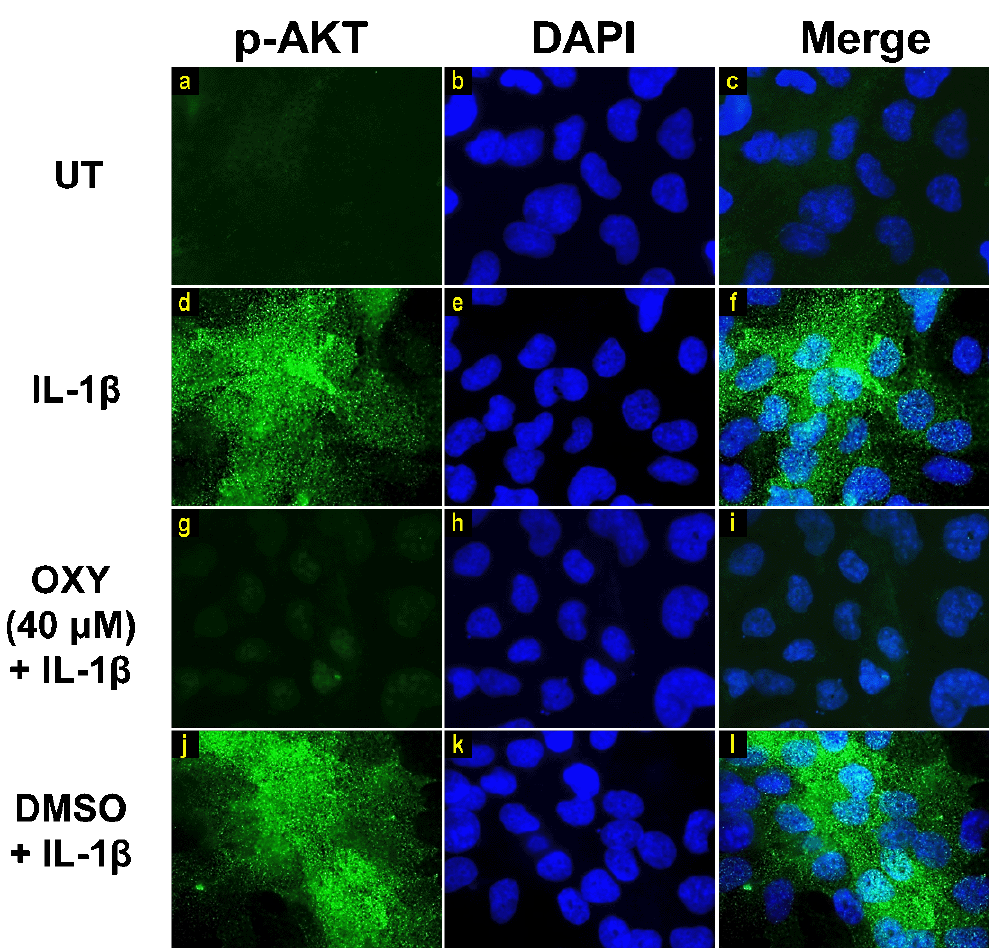
Figure 7. The effects of OXY on regulating AKT phosphorylation in cells stimulated with IL-1β. Representative images from immunofluorescence study showing AKT phosphorylation at Ser473 (green) of untreated cells ( a–c ), IL-1β-stimulated cells ( d–f ), IL-1β-stimulated cells with the presence of OXY at 40 μM ( g–i ), or DMSO ( j–l ). Nuclei (blue) were stained with DAPI. The micrographs were captured at 100× magnification, and data are representatives of three replicates.